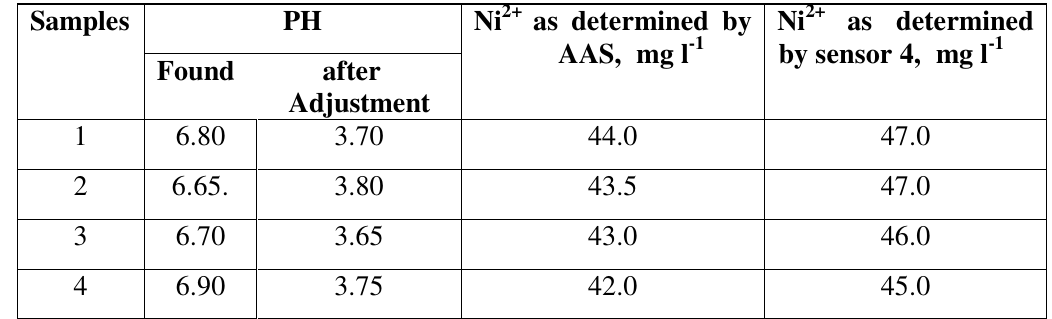
Table 4 : Nickel concentration in effluents from electroplating industry as determined with AAS and membrane